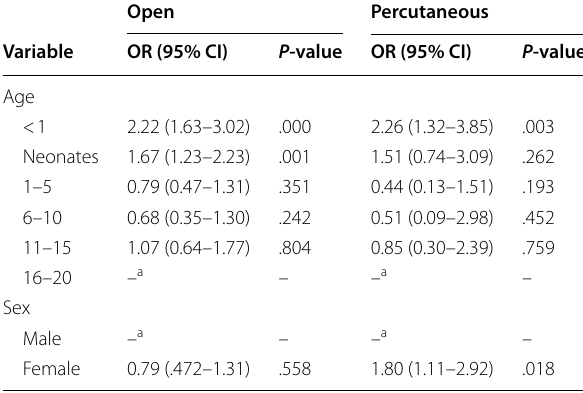
Table 1 Patient sex and percentage share of procedure cohort, OT and PT approaches